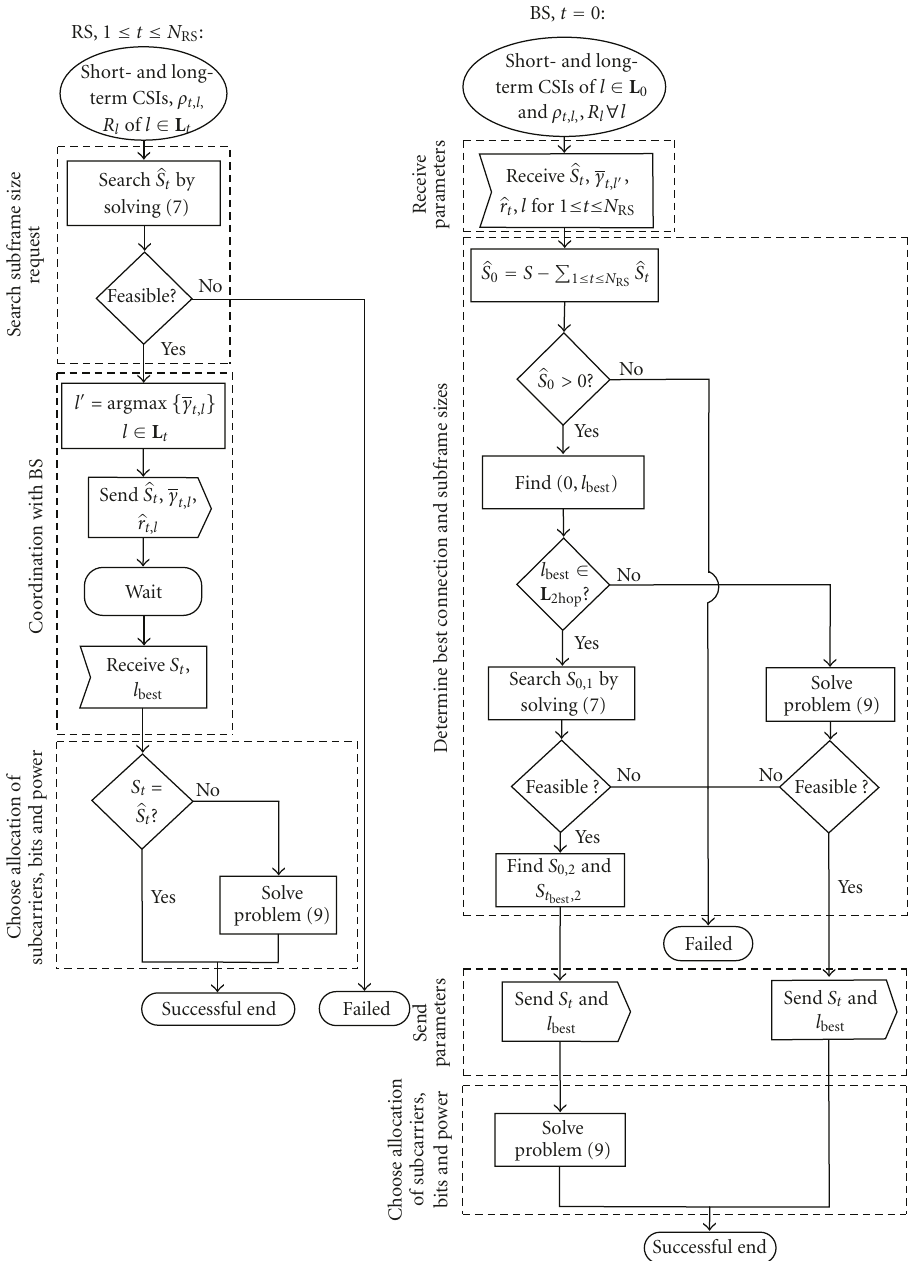
Figure 1: Flow chart of the coordinated resource allocation